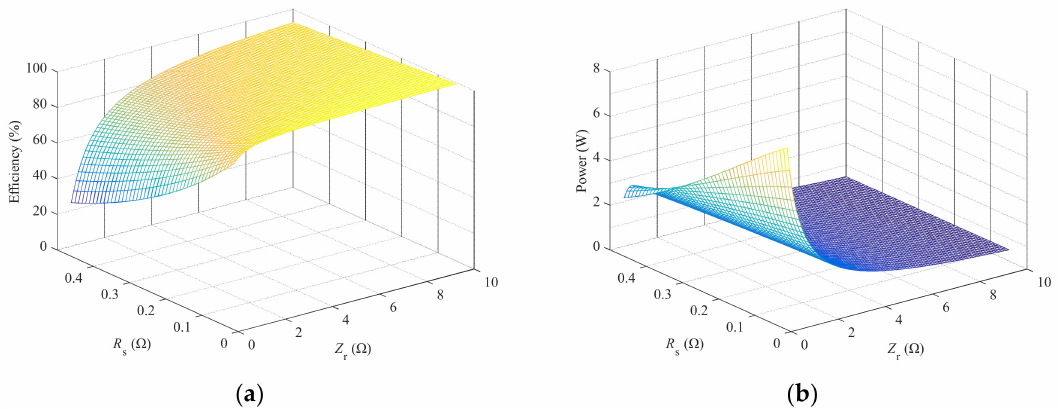
Figure 8. The influence of Z r and R s on balancing efficiency and power of the proposed equalizer at V BS = 4 V and V BT = 3.9 V. ( a ) Efficiency surface. ( b ) Power